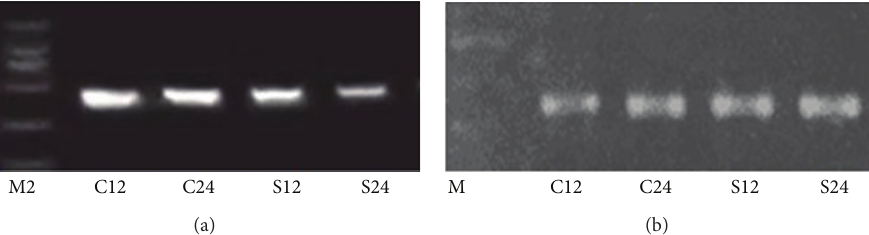
Figure 2: (a) BCL-2 and (b) Bax RT-PCR analysis of the aortic endothelium in the experimental and control groups after 12 hours and 24 hours.